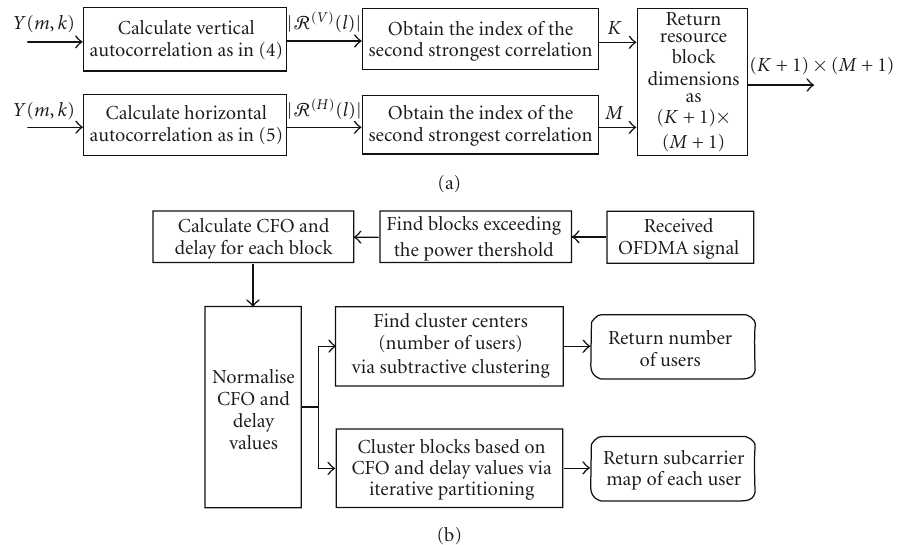
Figure 1: (a) Flowchart for block size estimation. (b) Flowchart for user signal